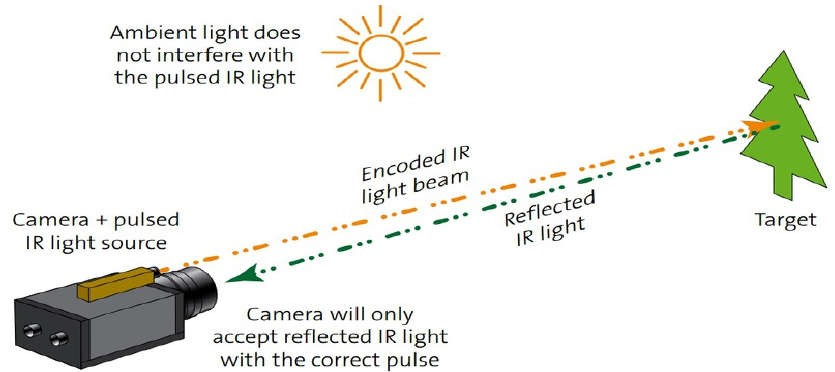
Figure 5. Time-of-Flight concept. Measuring travel time distance from IR light to the target and back to the camera [29].